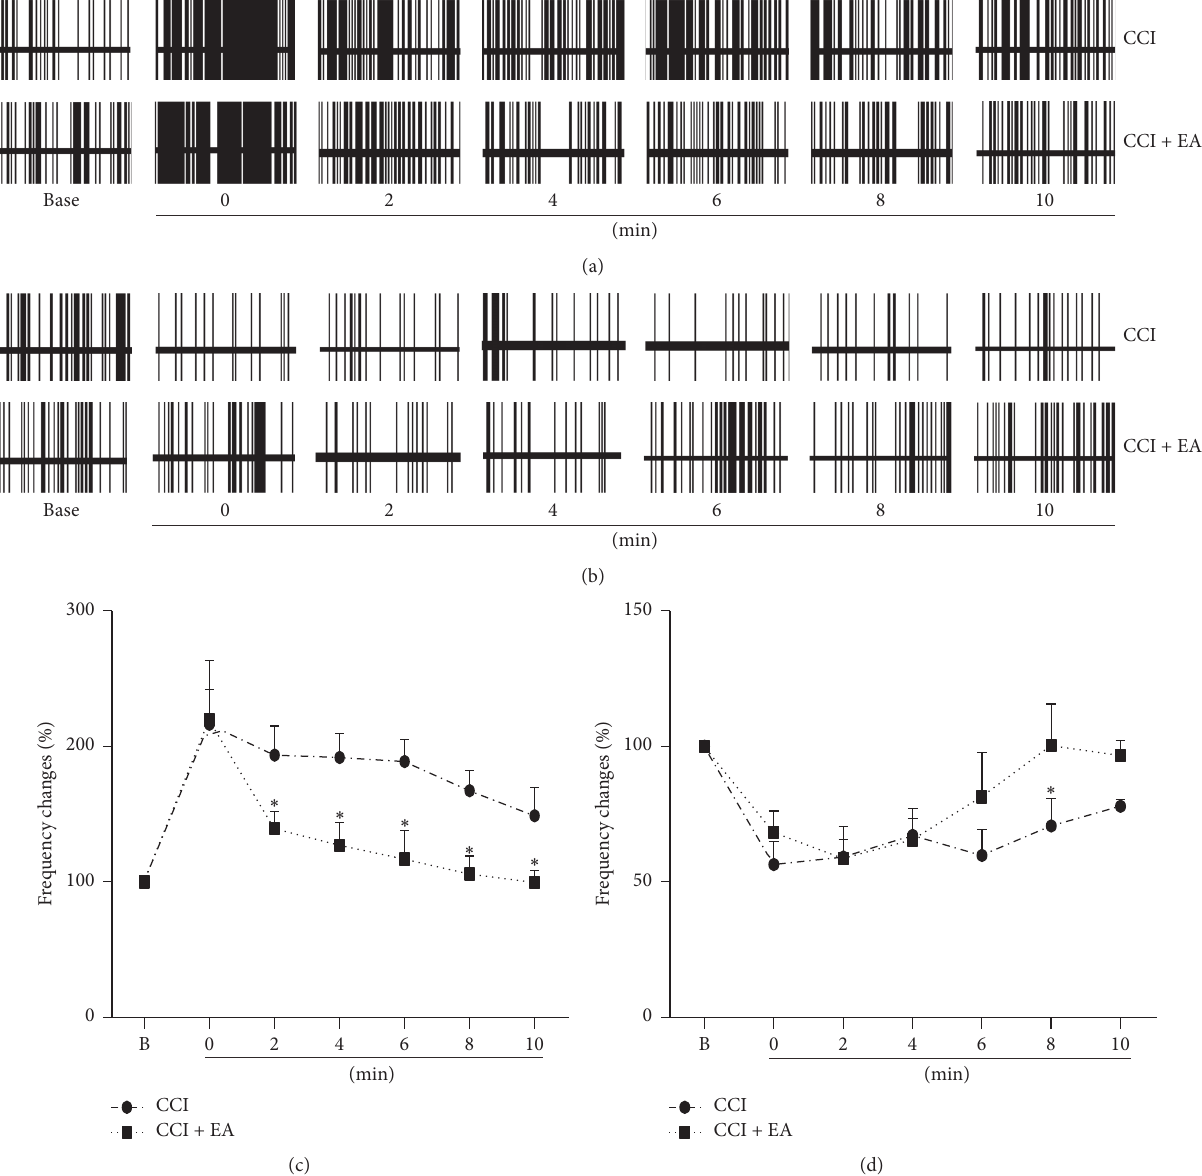
Figure 2: EA reduced the excitatory effects of brief sciatic nerve stimulation on the firing rate of PENs and had a similar reducing effect on PINs in CCI rats. (a) Example of EA reducing the effects of acute noxious stimulation on discharges of hippocampal PENs in CCI rats. (b) Example of EA regulating the effects of acute noxious stimulation on discharges of hippocampal PINs in CCI rats. (c) EA reduced the effects of acute noxious stimulation on the firing rates of hippocampal PENs ( 𝑛 = 14 ) at different times after the noxious stimuli in CCI rats. (d) EA reduced the effects of acute noxious stimulation on the firing rates of hippocampal PINs ( 𝑛 = 4 ) at different times after the noxious stimuli in CCI rats. B on the 𝑋 -axis stands for the background firing rate before the noxious stimulus. ∗ : compared with the CCI group, 𝑃 < 0.05